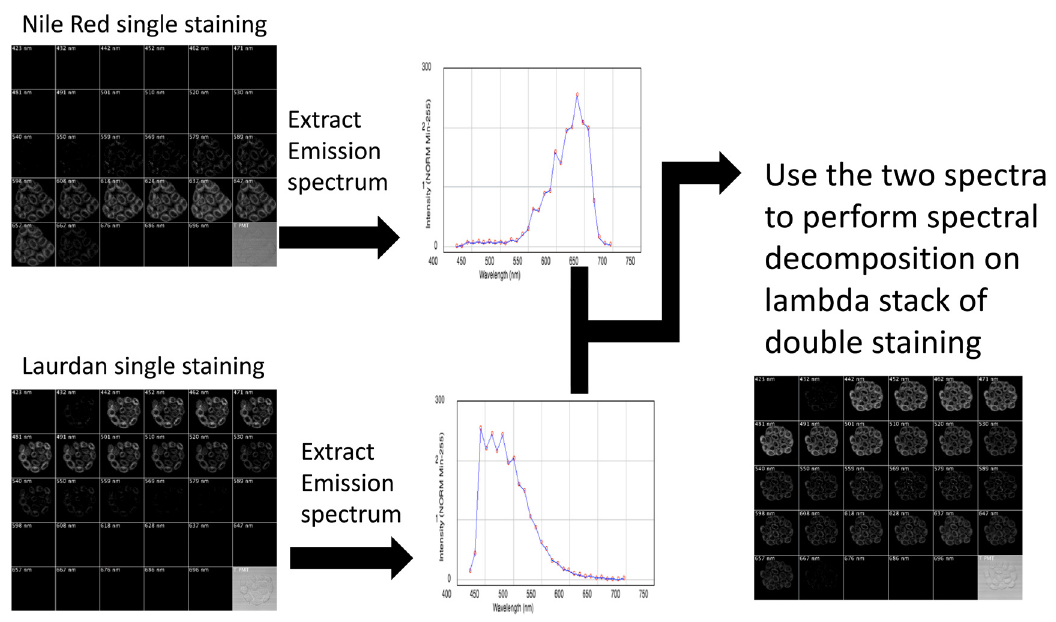
Figure 1. Scheme of the double staining and spectral decomposition procedure. To perform spectral decomposition on live cells labelled with two fluorescent dyes, we first acquired lambda stacks of cells labelled with either Nile Red or laurdan. The emission spectra of the dyes were then extracted from those stacks. Those emission spectra were then used to perform spectral decomposition on the lambda stacks acquired from cells stained with both dyes (bottom right